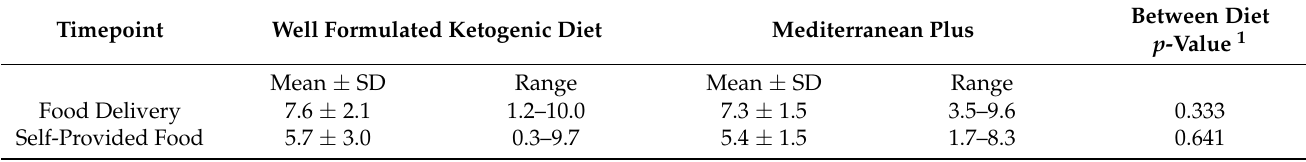
Figure 1. Nutrient data for means of ( A ) macronutrients, ( B ) carbohydrates, ( C ) whole and refined grains, ( D ) fats, and ( E ) animal and plant proteins at four time points (baseline, food delivery, self-provided and follow-up). Two bars are shown for food delivery and self-provided phases for comparison of data on each of the study diets (WFKD and Med-Plus). Table 4. Comparison of Adherence Scores between Keto–Med Randomized Trial Diet Phases by Timepoint (maximum adherence score =